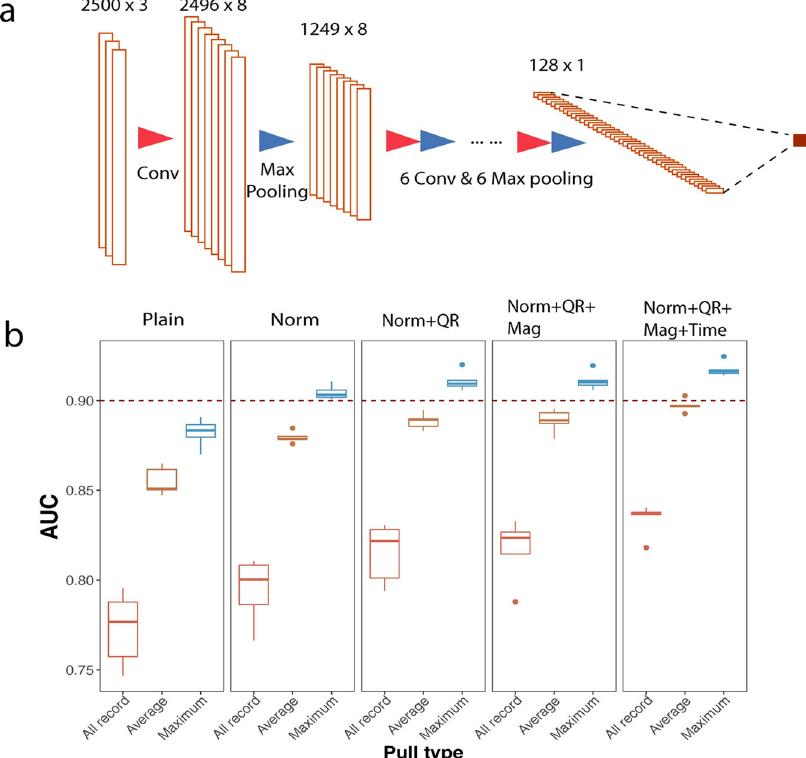
Fig. 2 Augmentation and normalization improve the performance of the tapping accelerometer model. a represents the model structure for the accelerometer data tapping model with seven convolutional layers, seven max-pooling layers, and 1 fully connected layer. b “ Plain Model ” represents the model using raw data without augmentation or normalization. “ Norm ” represents the model with Z-score normalization. “ Quaternion Rotation ” (QR), “ Magnitude ” , and “ Time ” denote the three types of augmentation methods. The data were pre-processed in sequential order of the methods shown above the plot. “ All record ” indicates the performance evaluated on the record level; “ Average ” and “ Maximum ” represent the individual level performance by using the average or the maximum prediction of all records of the same individual. The models with normalization and all augmentation methods showed the top